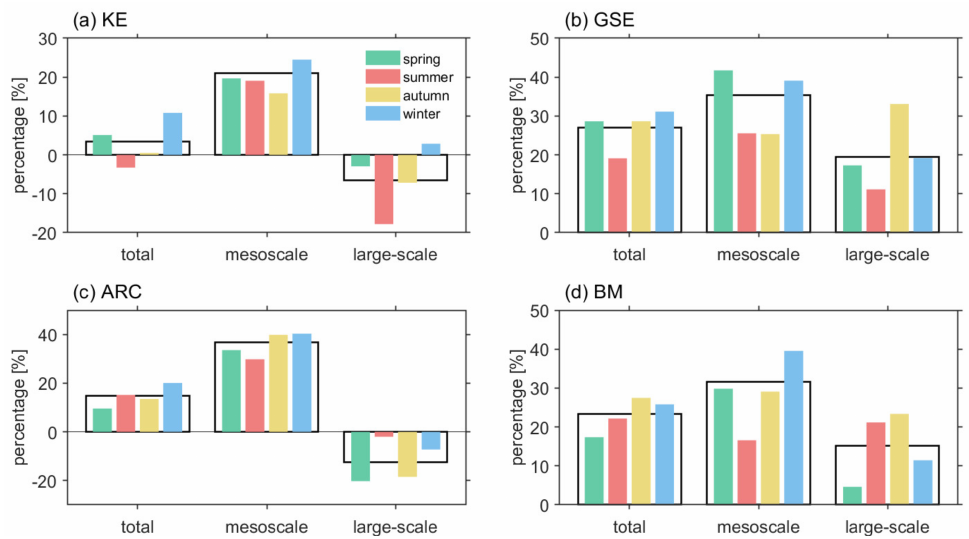
Figure 11. The rate of total, mesoscale, and large-scale SST variance change during 2007–2018, compared with the period of 1993–2006 in different seasons in the ( a ) KE, ( b ) GSE, ( c ) ARC, and ( d ) BMC regions based on the OI.v2-AVHRR-only data. The green, red, yellow, and blue bars denote the seasons of spring, summer, autumn, and winter, respectively. The black outlines are the average values of the four